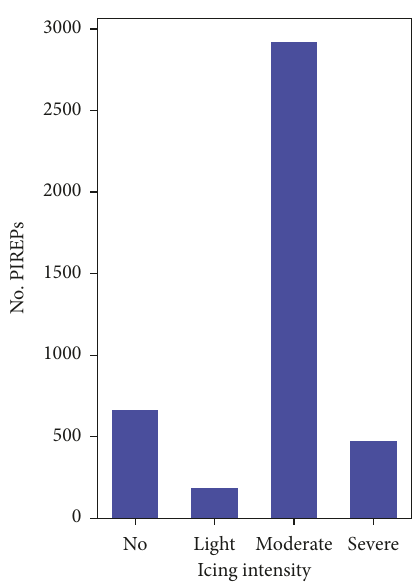
Figure 3: Frequency distribution of the icing intensity.